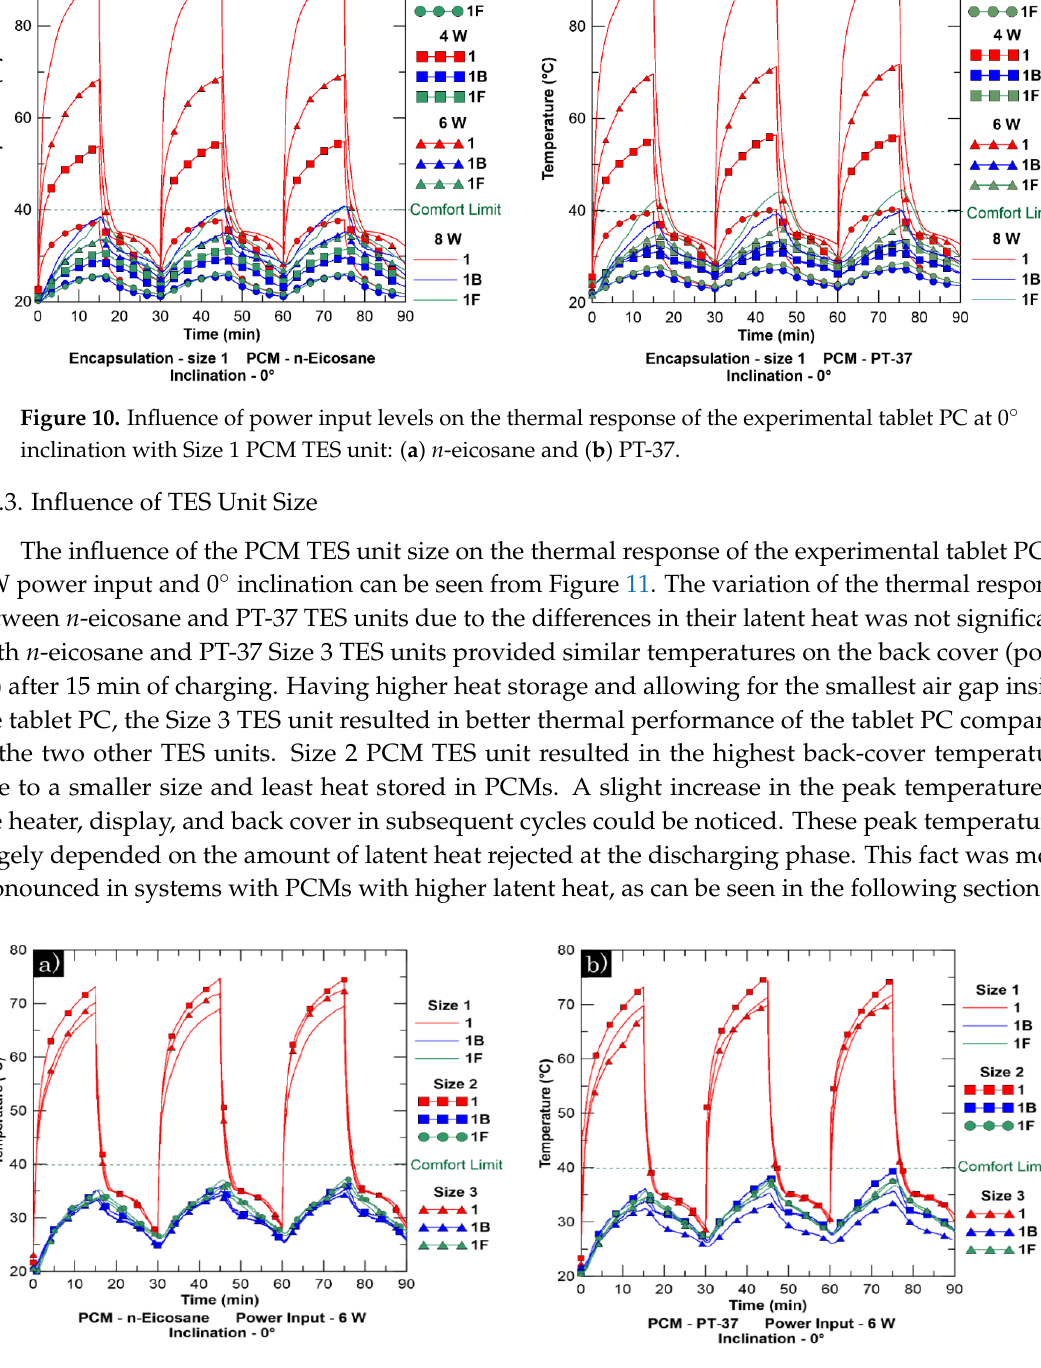
Figure 11. Influence of PCM TES size on the thermal response of the experimental tablet PC at 6 W power input and 0° inclination: ( a ) n- eicosane and ( b ) PT-37.